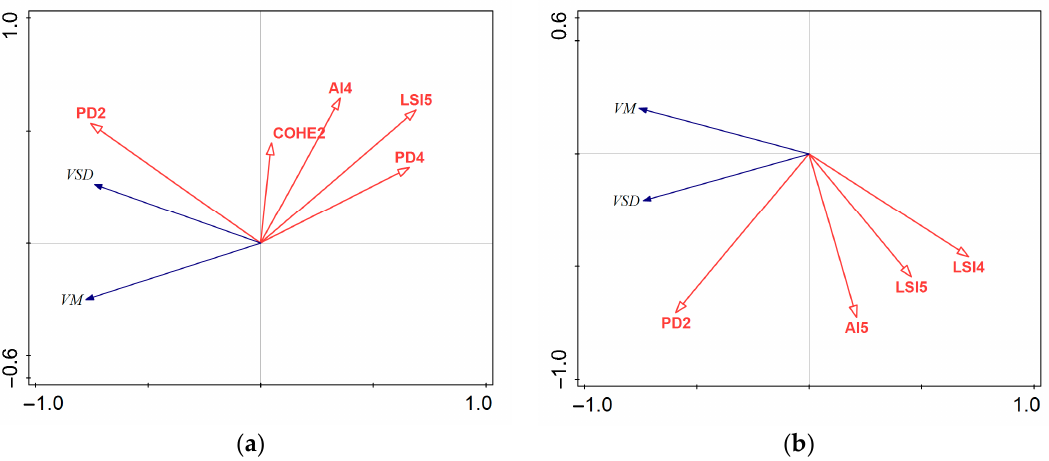
Figure 10. RDA ordination diagram with VM, VSD, and landscape metrics in the commercial area (COHESION was abbreviated as COHE due to length limitation): ( a ) 2000; ( b ) 2012. (Note: PLAND = Percentage of Landscape, PD = Patch Density, LPI = Largest Patch Index, LSI = Landscape Shape Index, AI = Aggregation Index, CONTAG = Contagion Index, COHESION = Patch Cohesion Index. VM = volume mean, VSD = Volume Standard Deviation. 1 = Manmade coverage, 2 = Waterbody, 3 = Woodland, 4 = Grassland, 5 = Bare